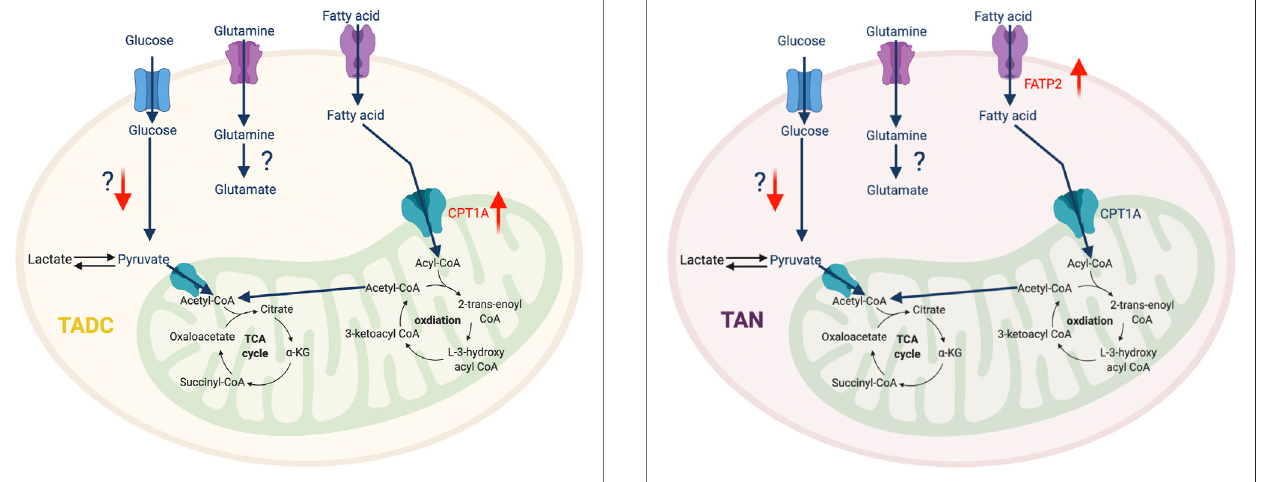
FIGURE 5 | The metabolic feature of TAN. Most metabolic pathways in TAN are not well-de fi ned, except that FATP2-mediated fatty acid metabolism plays an important role in their pro-tumorigenic phenotype. “ ↑ ” indicates “ increase. ” FATP2, Fatty acid transport protein